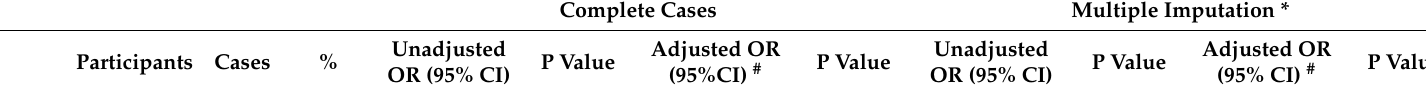
Table 4. Associations between the study factors and postnatal depressive symptoms (EPDS ≥ 13) in South Western Sydney and Sydney Local Health Districts,